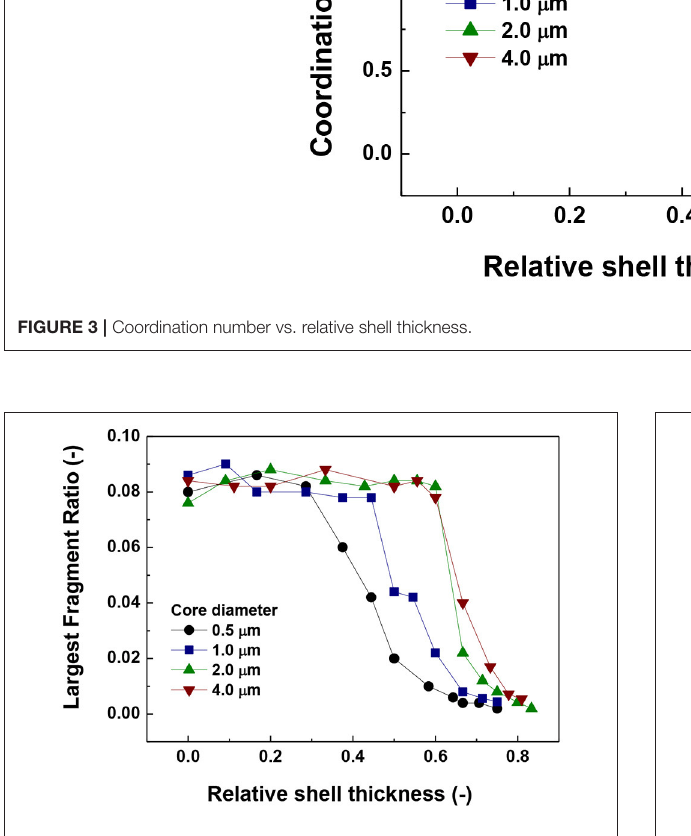
comparison for cases of shell thickness equal to 50nm (06-C05 and 41-C40) and two values of relative shell thickness of 0.17 (06-C05, 48-C40) and 0.67 (15-C05 and